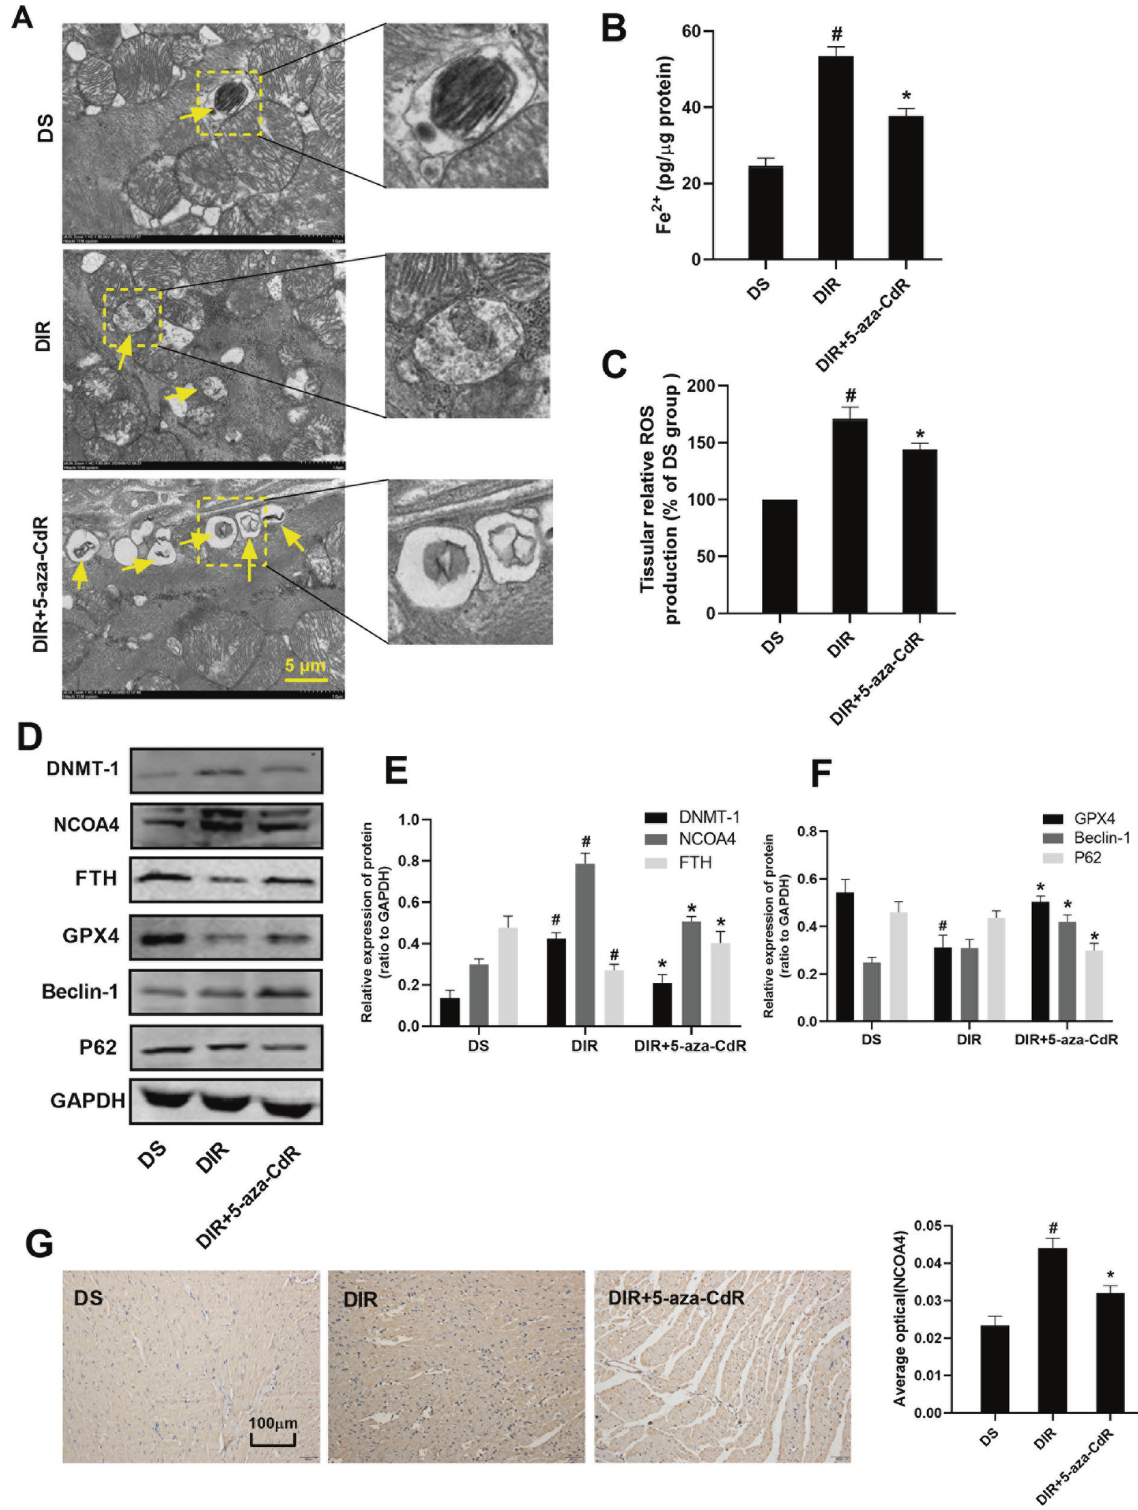
Fig. 4 Effect of DNMT-1 on autophagy-ferroptosis axis in myocardial tissue. A The changes of autophagosome in myocardial tissue were detected by electron microscopy. B Fe 2 + in myocardial tissue was detected. C ROS in myocardial tissue was detected. D – F The protein expression of DNMT-1, NCOA4, FTH, GPX4, Beclin-1, and p62 in myocardial tissue was detected by western blotting. G The expression of NCOA4 in myocardial tissue was detected by IHC. Results are presented by means ± SD. n = 8 per group. # P < 0.05 compared with the DS group. * P < 0.05 compared with the DIR